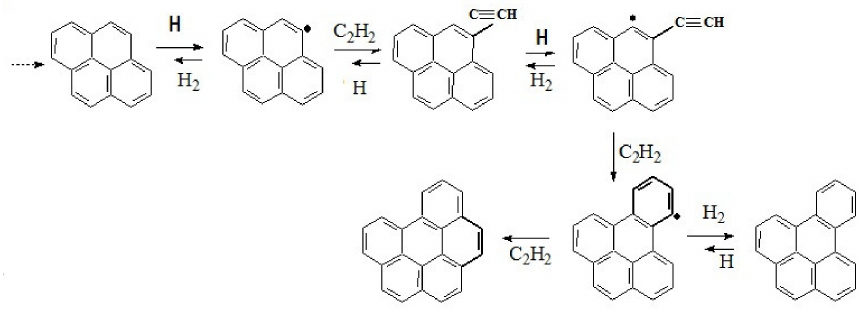
Figure 14. The mechanism of formation of the precursor molecule.